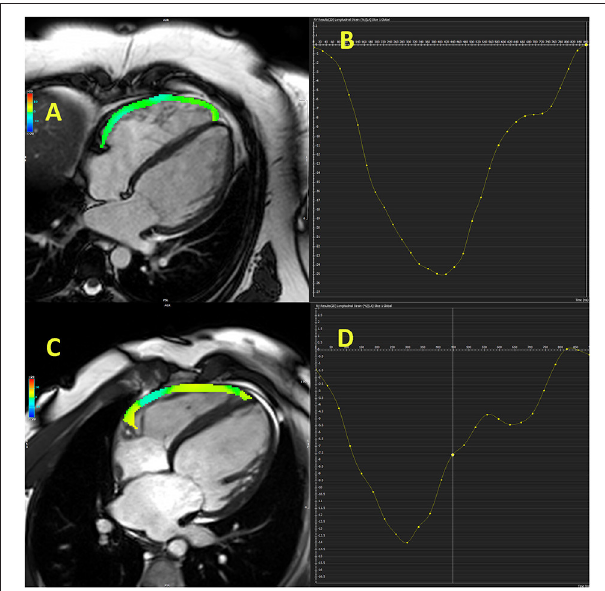
FIGURE 2 | Cardiac magnetic resonance-derived right ventricular free-wall longitudinal strain in control subject (A,B) and patient with heart failure with reduced ejection fraction (C,D)